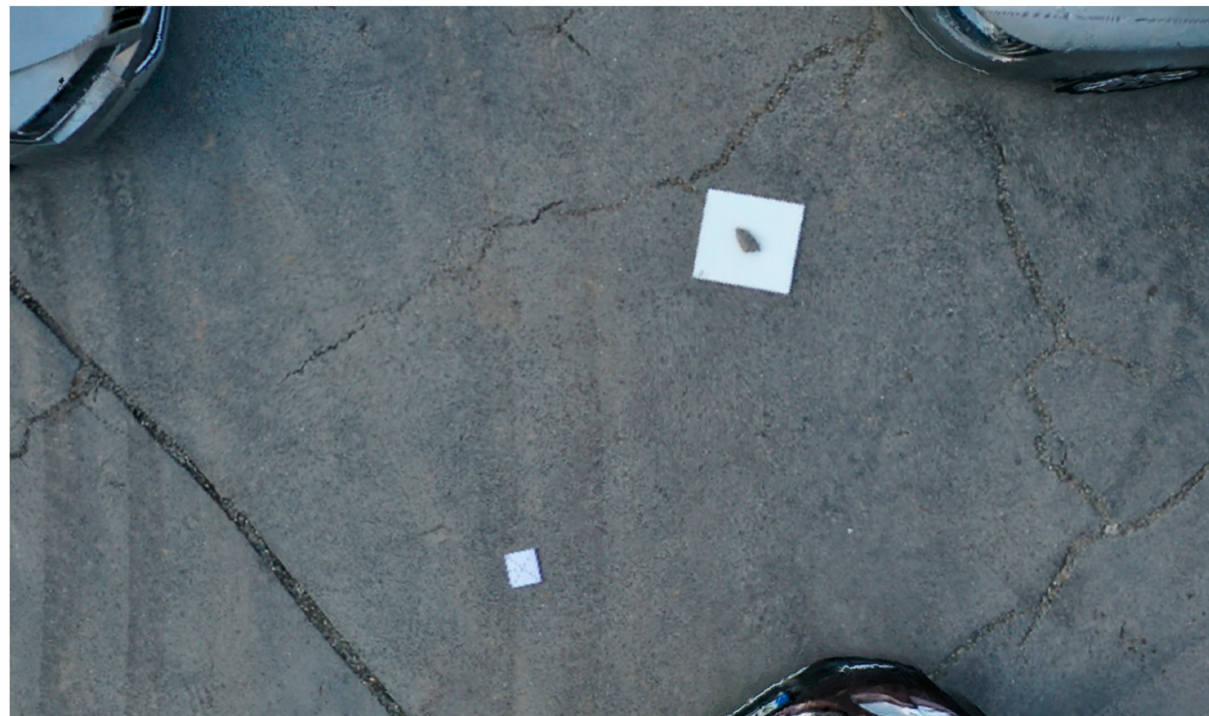
Figure 4. Detailed perpendicular view of the final model.